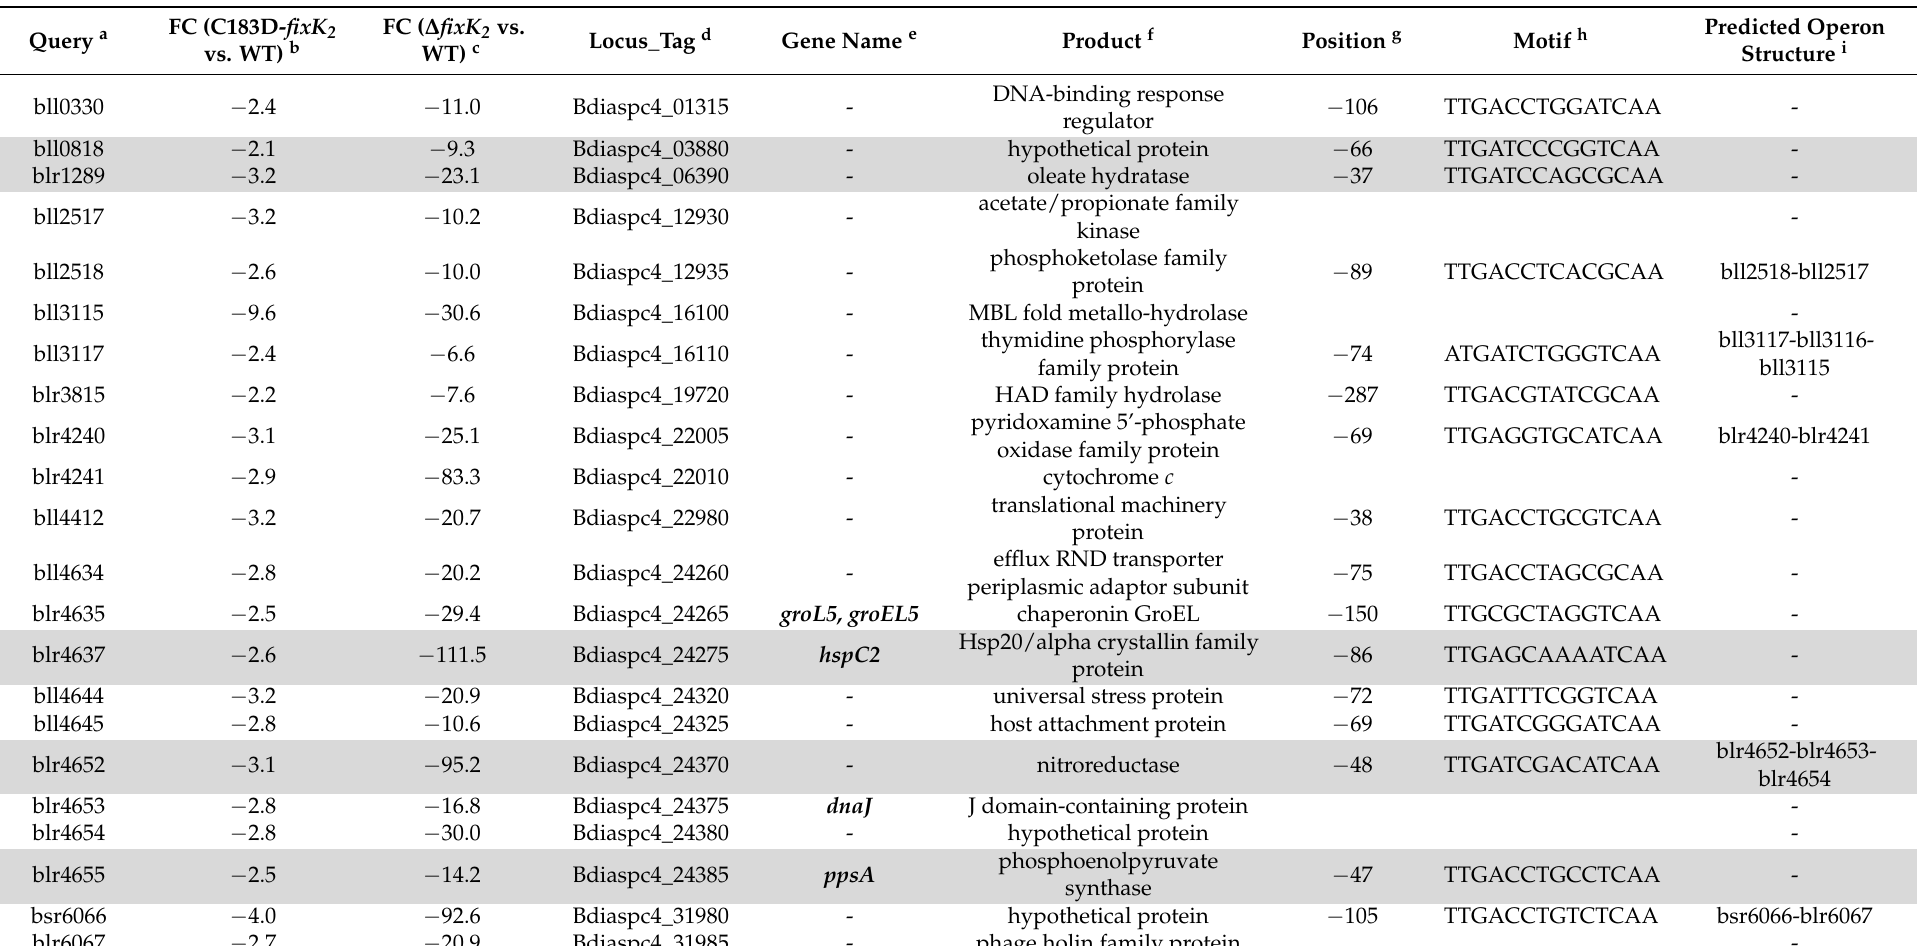
Table 2. List of the 37 genes belonging to 26 putative FixK 2 box-associated transcription units whose expression is downregulated in both the C183D- fixK 2